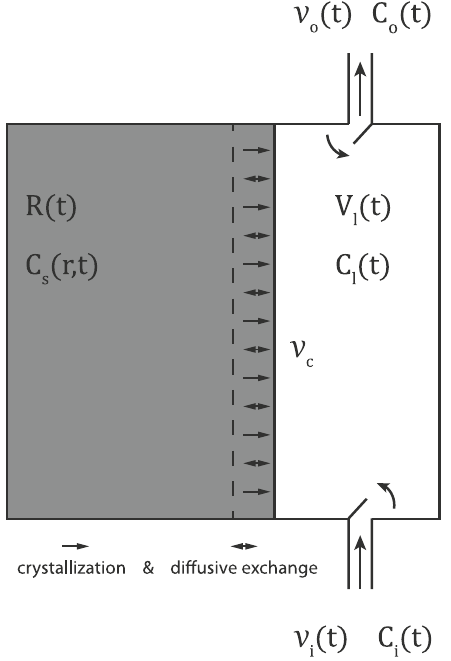
Figure 5. Schematic illustration of the model. Chemical component exchange between solid and melt occurs as a consequence of two processes: crystallization of the melt on the rim of the solid grain and because of diffusive exchange. The model considers both an inflow and outflow of melt in and out of the system, which may vary as the system evolves. The volume (per unit of surface) of corundum and melt are controlled by the crystallization ( v c ), inflow ( v i ) and outflow ( v o ) rates. Further details are given in the